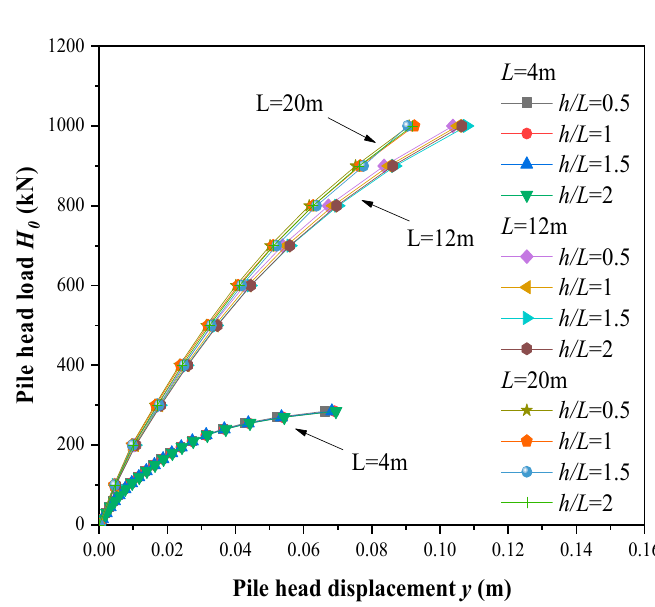
Figure 8. Effect of the slope height on pile head displacement of piles.